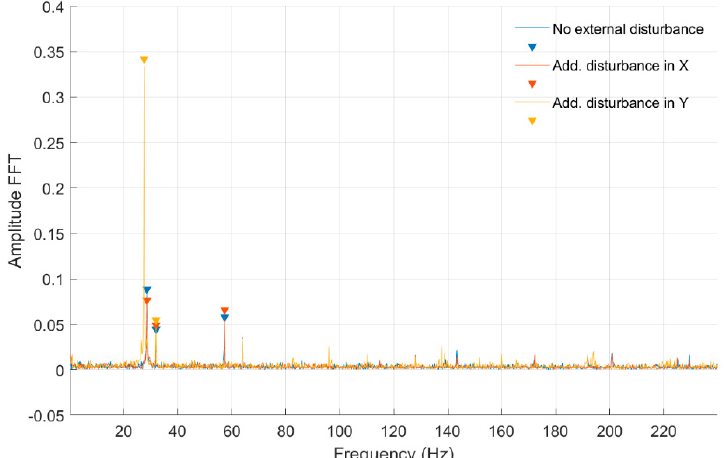
Figure 9. FFT of strain-level measurement for constant motor speed equal to 25 rev/s with disturbance from the control system for a quarter-bridge configuration (Node 955).